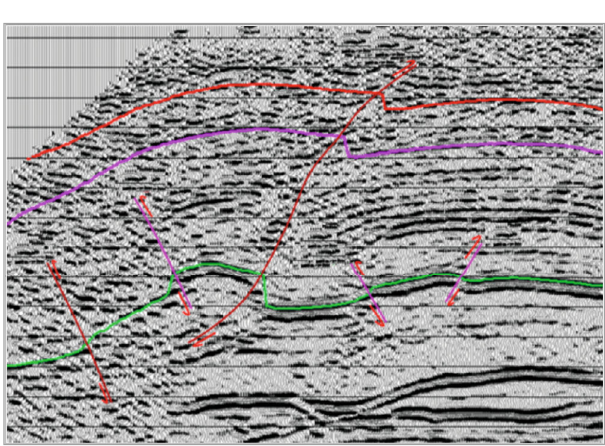
Figure 3: The seismic pro fi le of fault systems in the Ning209